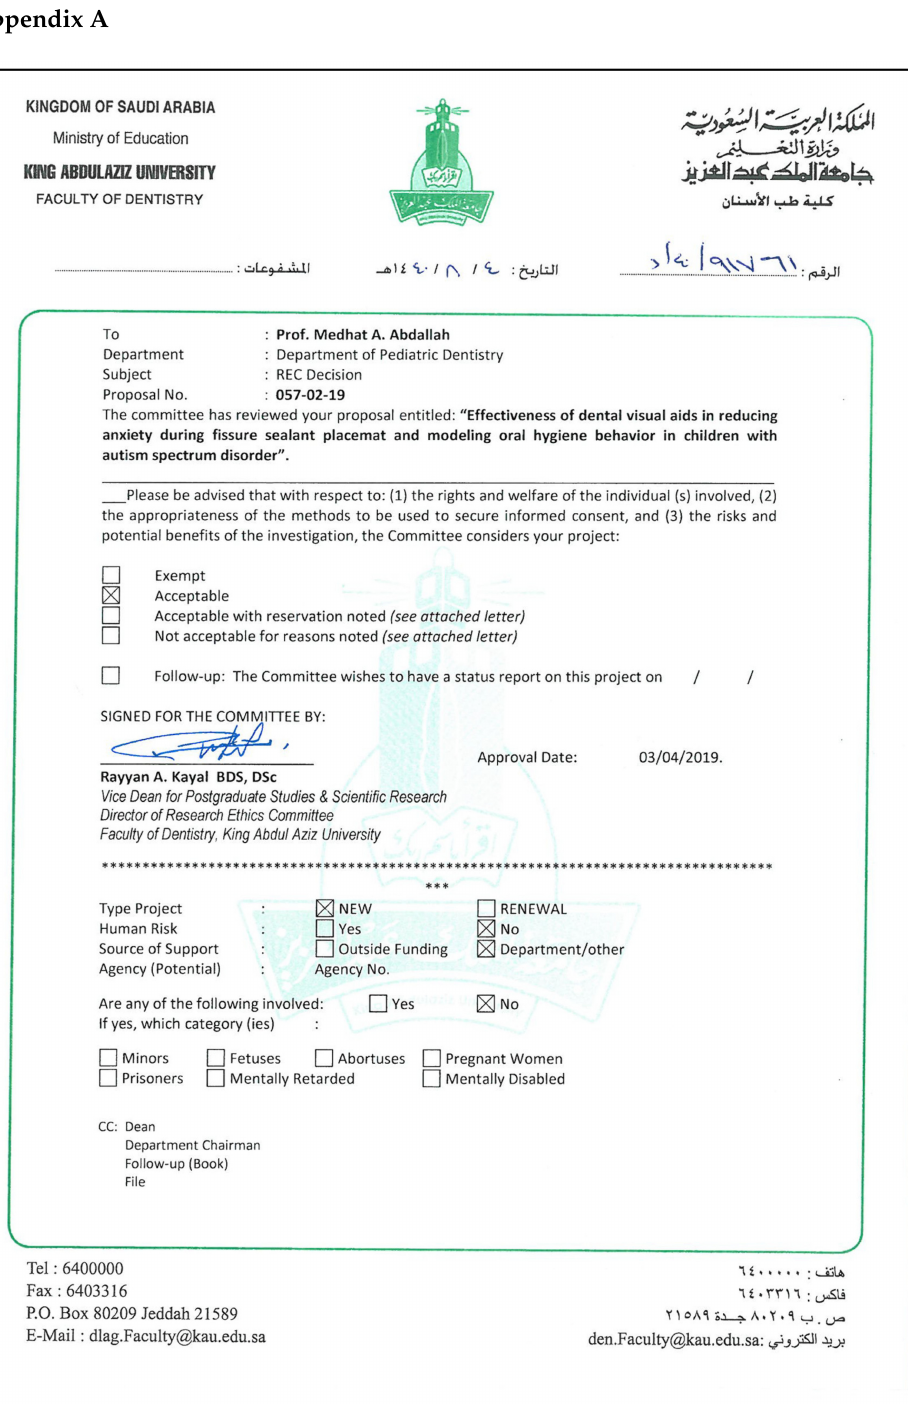
Figure A1. Ethical